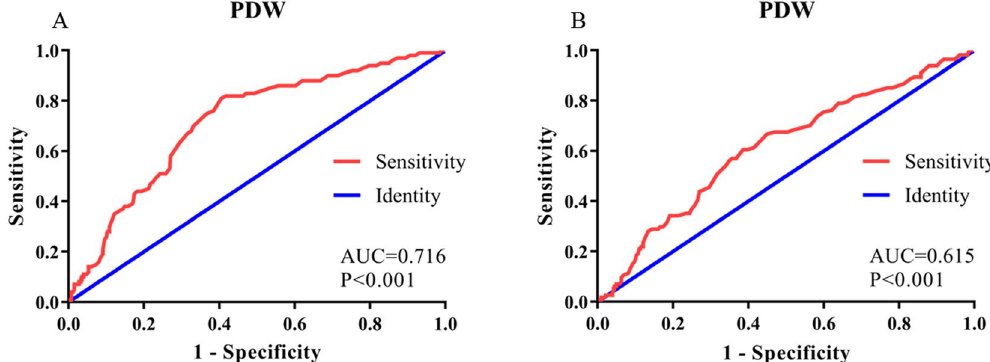
Figure 1. ROC curves analysis of PDW for survival outcomes in patients with ESCC. ( A ) OS revealed the largest AUC (0.716), while PDW cutoff was set at 13.4 for the largest Youden Index (0.405) obtained